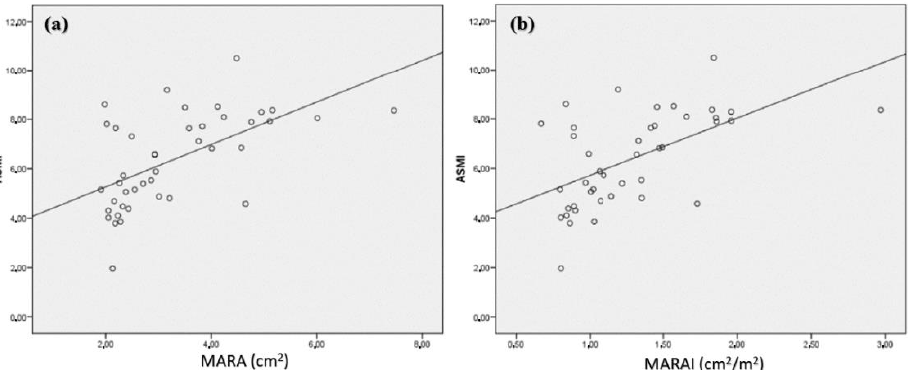
Figure 2. Correlation between estimated ASMI with MARA ( a ) and MARAI ( b ). MARA: muscular area rectus anterior, MARAI: muscular area rectus anterior index.